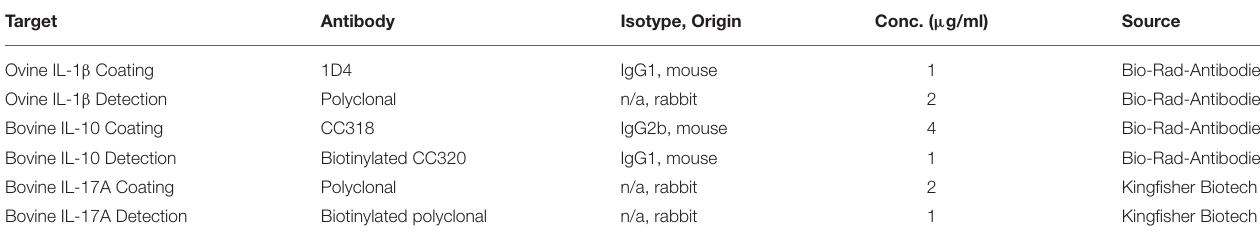
TABLE 1 | Details of antibodies used for cytokine